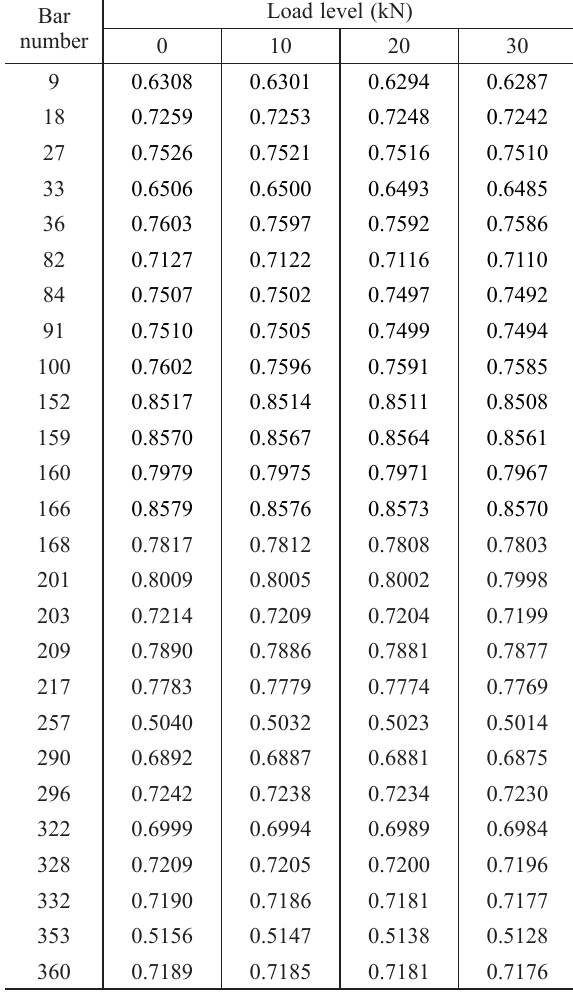
Table 8. Results of a square pyramid